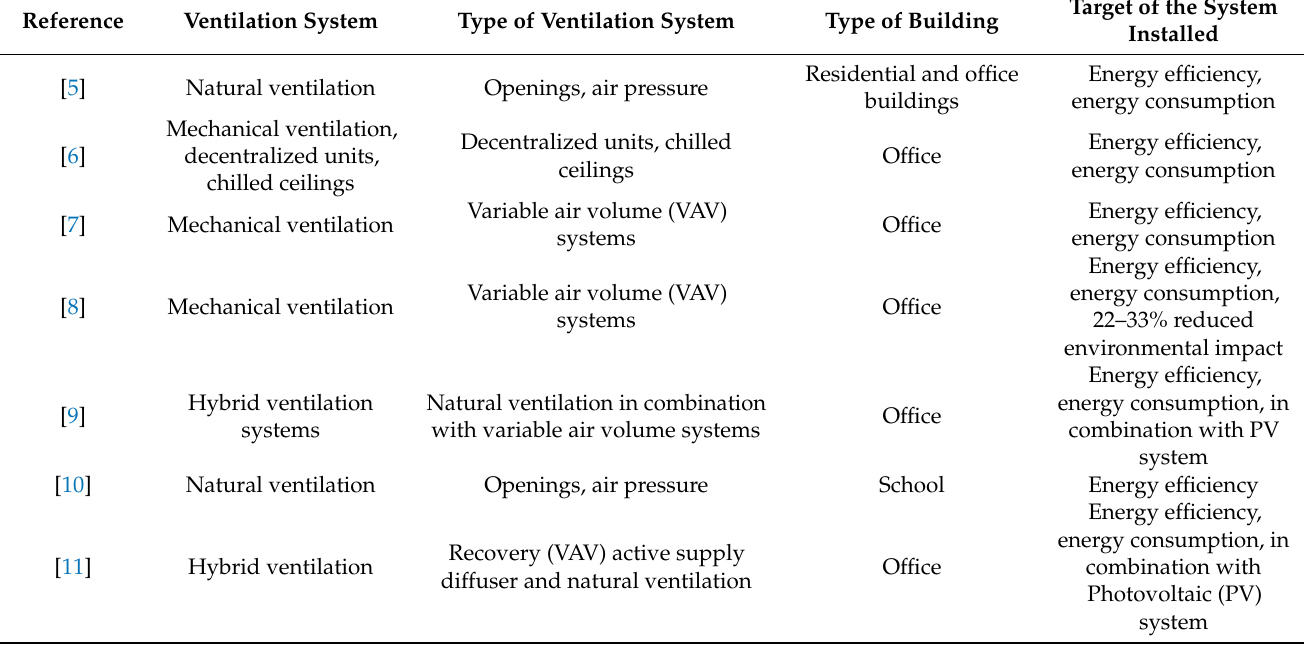
Table 1. State-of-the-art on ventilation system applications in buildings in terms of energy efficiency, indoor air quality, and environmental impact